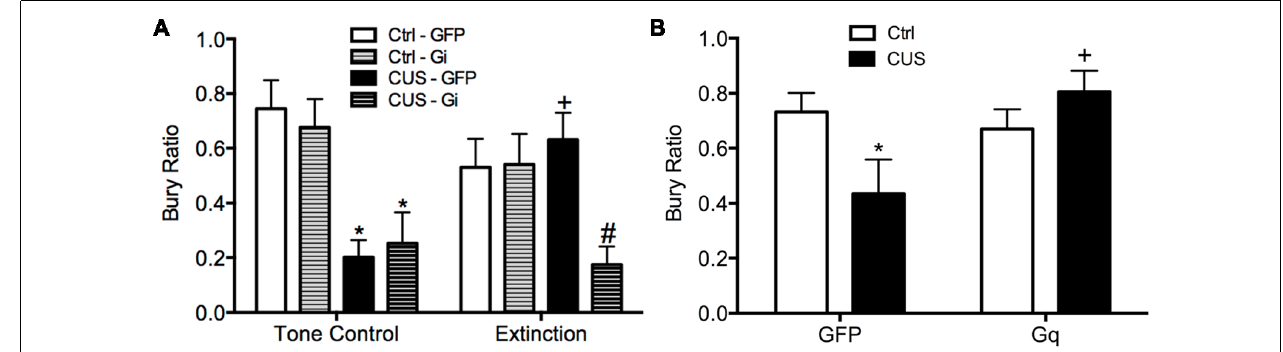
FIGURE 3 | Activity of glutamatergic pyramidal cells in the IL cortex is necessary and sufficient for the therapeutic effects of extinction on the shift from active to passive coping behavior induced by chronic stress on the SPDB test. (A) CUS induced a significant decrease in bury ratio ( ∗ p < 0.01, for both GFP/CUS/tone controls and hM4Di/CUS/tone controls compared with GFP/unstressed/tone controls). Extinction treatment reversed the effect of stress, restoring the bury ratio to unstressed control levels ( + p < 0.05, GFP/CUS/extinction compared with GFP/CUS/tone controls). Inhibition of glutamatergic neurons in IL during extinction prevented the therapeutic rescue of CUS-compromised bury ratio ( # p < 0.02, hM4Di/CUS/extinction compared with GFP/CUS/extinction); n = 9–14 per group. (B) CUS induced a significant decrease in the bury ratio ( ∗ p < 0.05, GFP/CUS compared with GFP/unstressed controls). Activation of glutamatergic neurons in IL after transfection with the excitatory hM3Dq Designer Receptor Exclusively Activated by Designer Drug (DREADD) reversed the effect of stress, restoring the bury ratio to unstressed control levels 24 h after CNO administration ( + p < 0.02, GFP/CUS compared to hM3Dq/CUS); n = 6–10 per group. Data expressed as mean ± SEM. Reproduced and adapted with permission from Fucich et al. (2018).